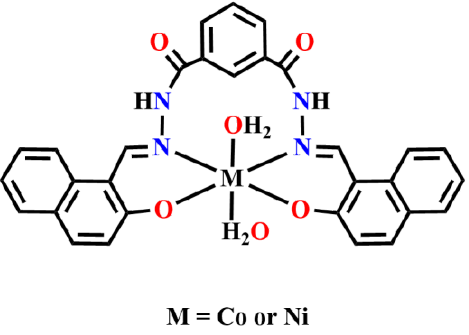
Figure 25. The six-coordinated Co(II)/Ni(II) complexes of m -benzenebisnaphthylhydrazone, with two H 2 O molecules as the axial ligand.